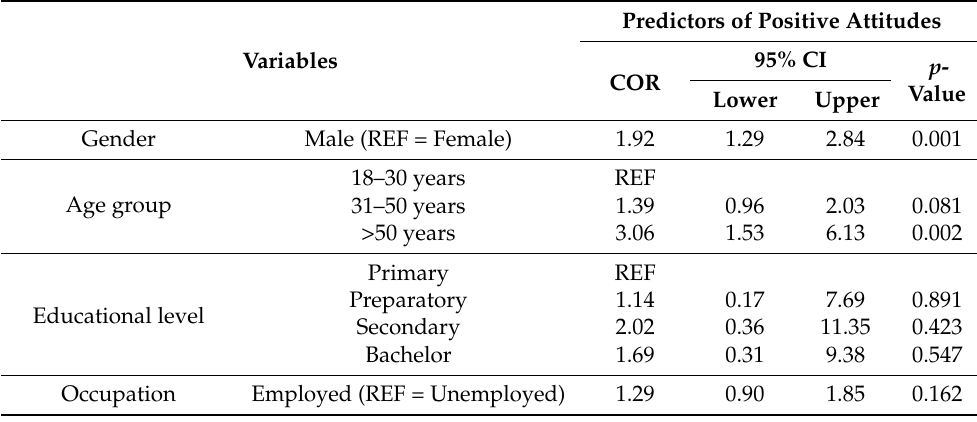
Table 6. Factors associated with positive attitudes toward